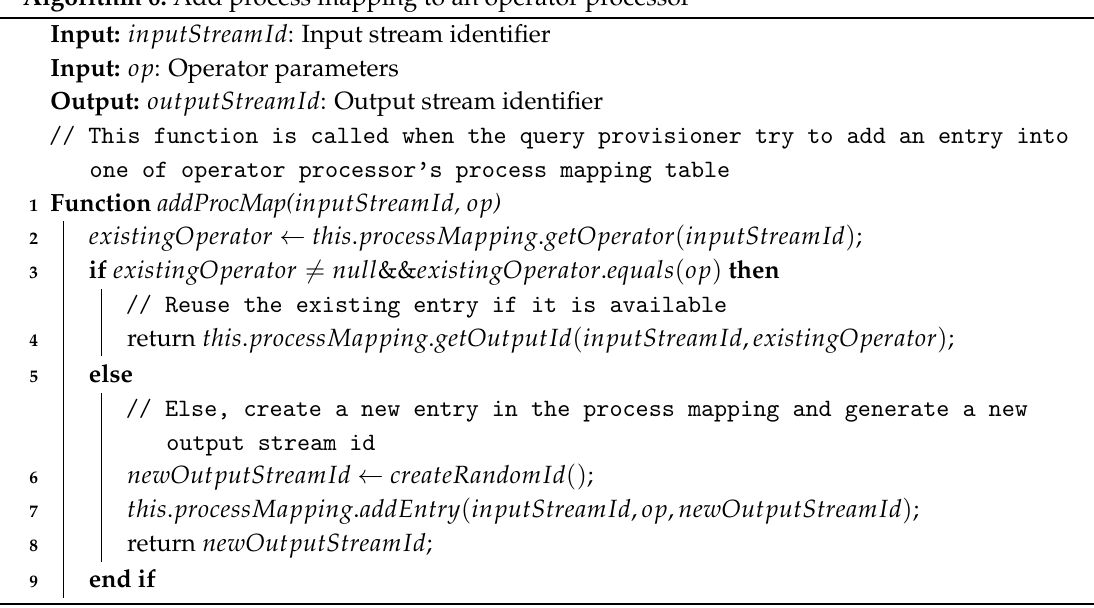
Algorithm 6: Add process mapping to an operator